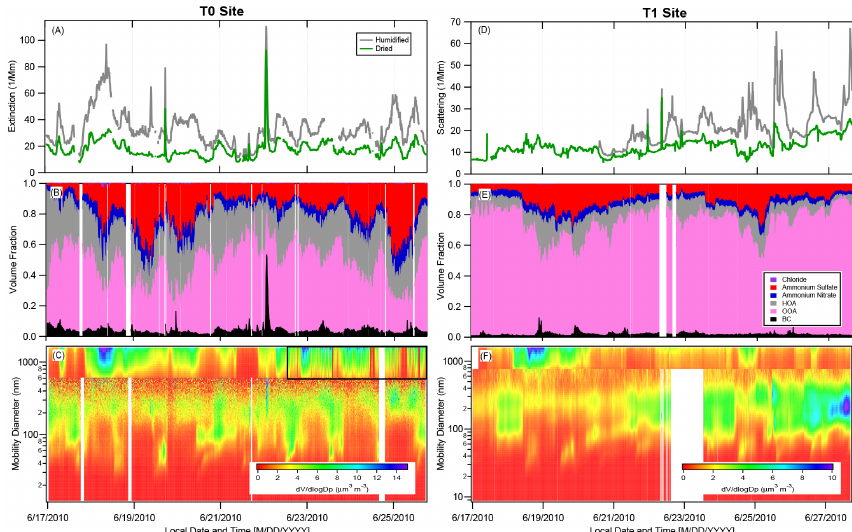
Figure 1. Overview time-series data of b ext at T0 (left panels) and b scat at T1 (right panels) for both humidified and dried particles (a) and (d) , volume fraction of the various submicron components, exclusive of water (b) and (e) , and composite volume-weighted size distributions (c) and (f) . Note that neither the vertical nor the horizontal scales are the same between the two sites/sets of panels. The black box around the last portion of the large particle size distribution at T0 (c) indicates the time period during which a synthetic size distribution was used, as described in the text.